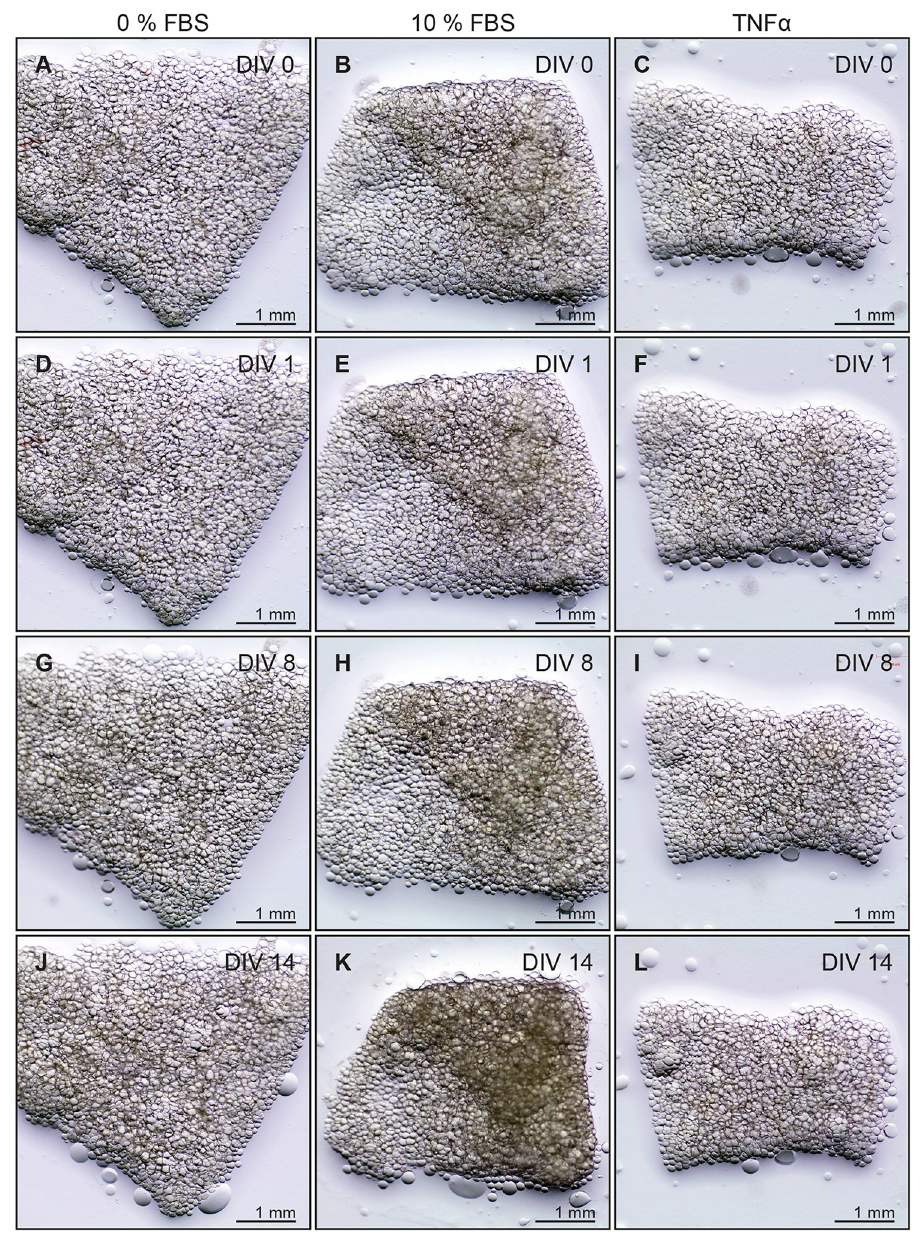
Fig 2. Macroscopic development of adipose tissue under different culture conditions. On defined points of time in each case the same slice was photographed using a Zeiss Stereomicroscope. A to C—0 th DIV. D to F—1 st DIV. G to I— 8 th DIV. J to L—14 th DIV. Left column—0% FBS. Middle column—10% FBS. Right column—TNF α .